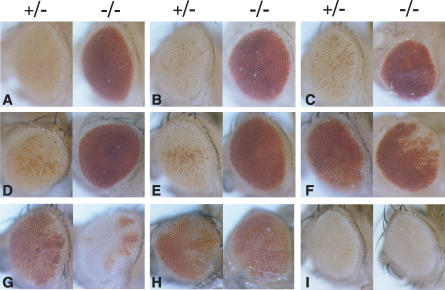
Chromosome 4 Variegating Transgenes Are Derepressed in DmSetdb110.1a HomozygotesEyes pictures showing expression of variegating white transgenes on Chromosome 4 (A–E) and other chromosomes (F–I), in DmSetdb110.1a heterozygous (+/−) and homozygous (−/−) background. Wild-type flies show the same phenotype as DmSetdb110.1a heterozygotes (unpublished data). Pictures show heterozygous and not wild-type flies, because heterozygous and homozygous mutant flies were generated from the same cross and are thus directly comparable. Genotypes were analyzed by PCR. (A) corresponds to the 39C12 P element, (B) to 39C72, (C) to 118E10, (D) to 6M193, (E) to 118E15, (F) to 39C3, (G) to the In(1)wm4h inversion, (H) to Heidi, and (I) to 39C5. P elements in (A–E) are inserted on Chromosome 4 arm, in (F) and (H) near Chromosome 2 centromeric heterochromatin, in (I) near telomere of 2L, and (G) is an inversion on Chromosome X relocating the endogenous white gene next to centromeric heterochromatin. For genotypes, see Materials and Methods.